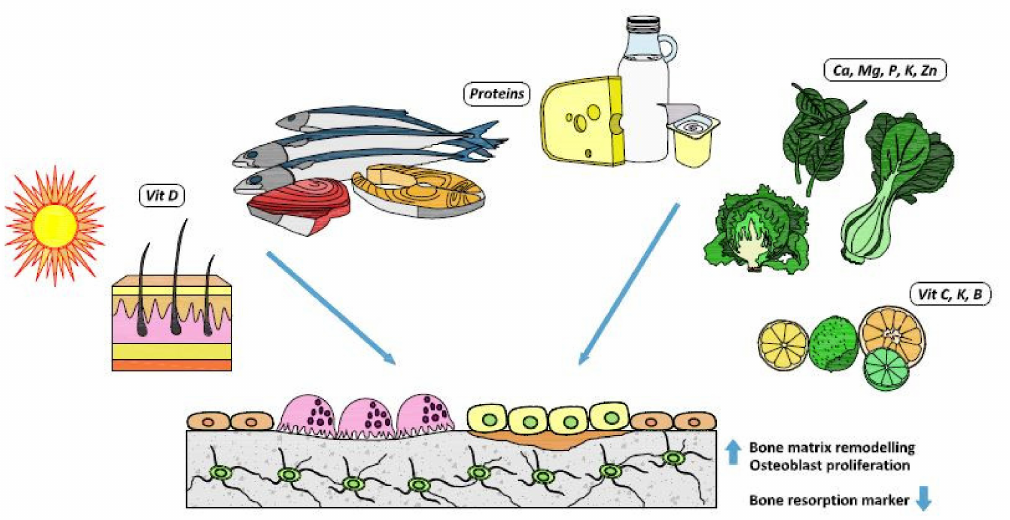
Figure 1. Nutrients and their bone e ff